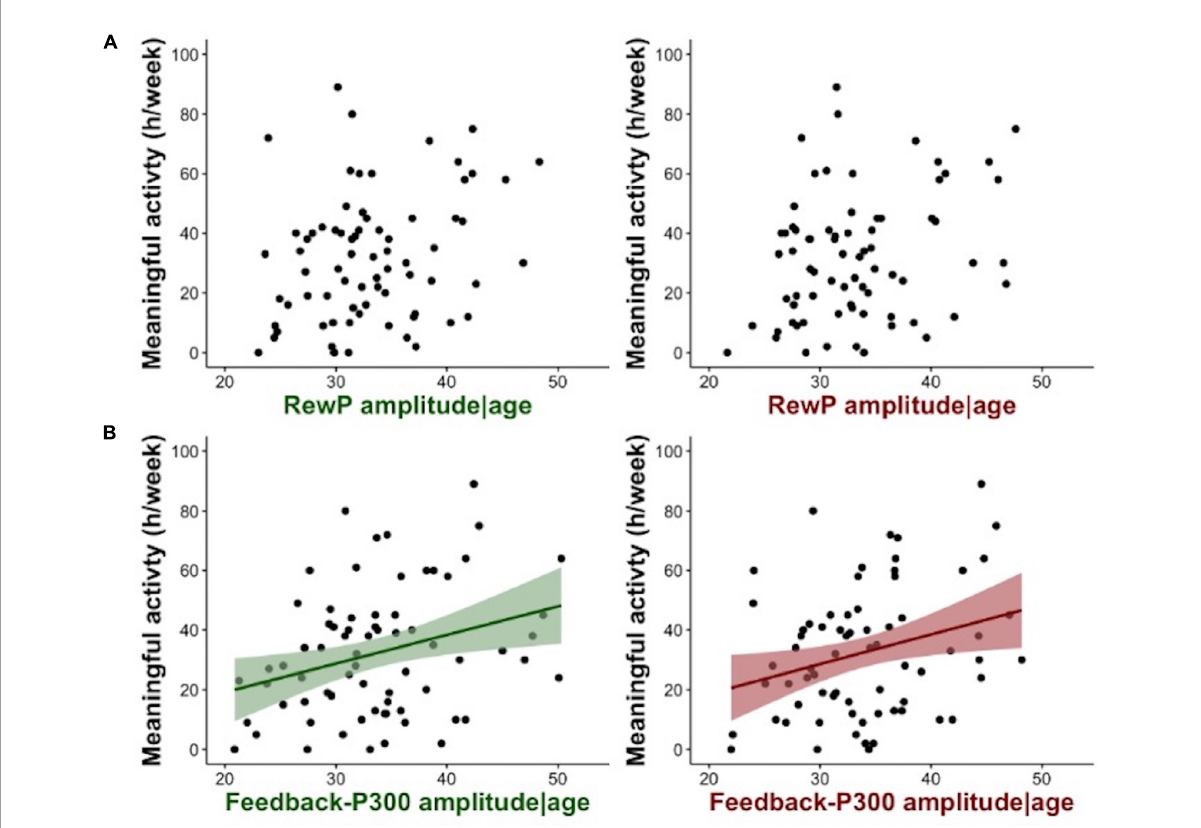
FIGURE3 (A) Shows scatterplots of the relation between RewP gain feedback condition (in green) or RewP loss feedback condition (in red) adjusted for the effects of age, and time spent on meaningful activity in a week. (B) Shows the relation between FB-P3 gain feedback condition (in green) or FB-P3 loss feedback condition (in red) adjusted for the effects of age, and meaningful activity. Shading shows the 95% confidence